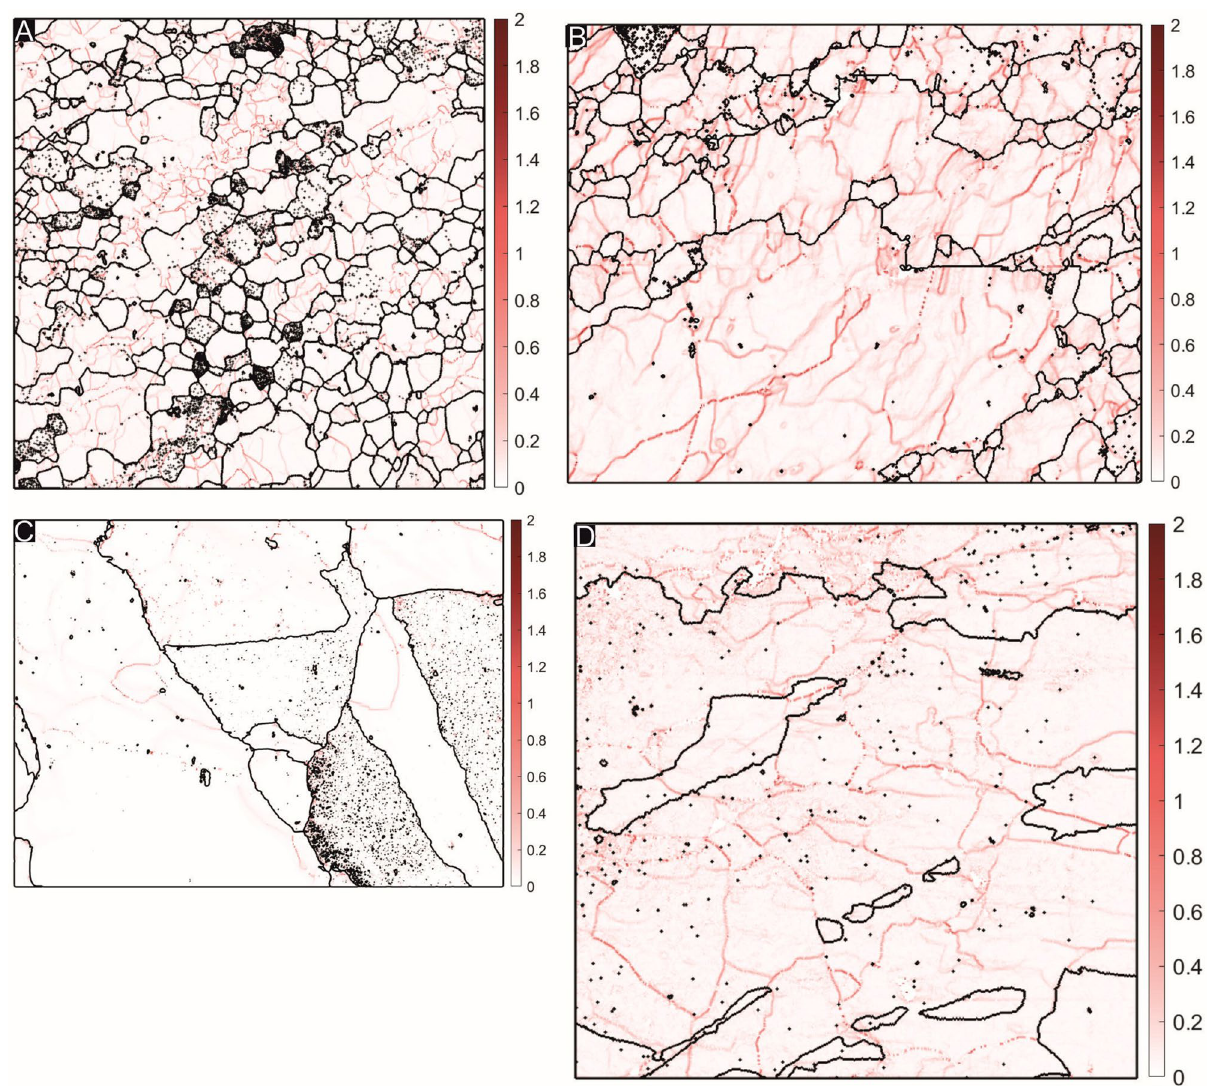
Figure 4. Kernel Average Misorientation maps of four representative quartzite samples used in this study, generated using the software package Mtex version 5.6.0 for Matlab. (Matlab version 2020a). URL: https:// mtex- toolb ox. github. io/. Varying shades of red describe the misorientation angle at different points in the map; ( A ) RN 178: sheared quartzite from the Rengali Province. Larger grains have a significantly higher amount of strain (dislocations) compared to smaller grains, as is expected for incomplete dynamic recrystallization. In some grains, dislocations are perpendicular to the grain boundary lengths. ( B ) RN 221: sheared quartzite from the Rengali Province. Comparatively larger grain size compared to A, because of which the density of dislocations is higher. Smaller grains are almost dislocation free whereas large grains have dense concentrations of dislocations within them. ( C ) RN 36: statically recrystallized quartzite from the Rengali Province. Almost strain free, with very few isolated dislocations in the grain interiors. Static recrystallization and accompanying polygonization without further strain imprint appears to have left this quartzite relatively strain free. ( D ) RN 235: quartzite deformed under granulite facies conditions. Large amoeboid grains with a significant dislocation density are the dominant feature of this quartzite. Smaller recrystallized grains appear to be relatively strain